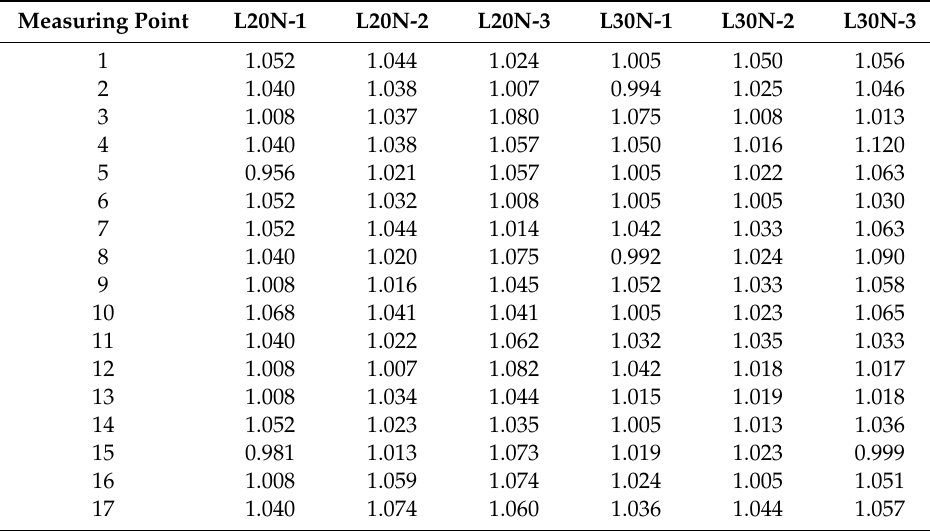
Table A1. The fractal dimension